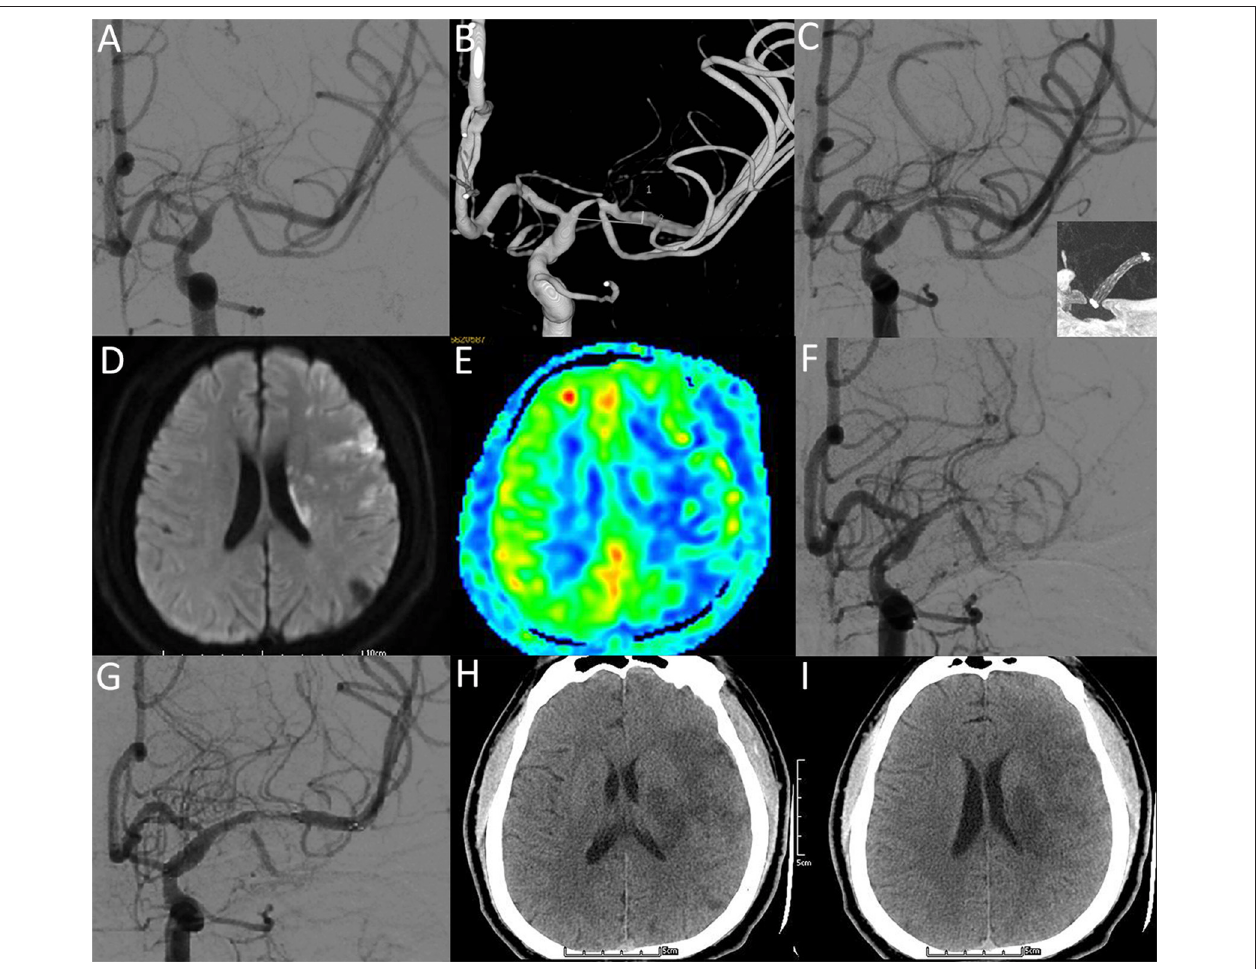
FIGURE 4 | A 28-year-old male with a significant symptomatic stenosis of the left M1 segment. (A,B) Preprocedural DSA image demonstrates high-grade stenosis. (C) Postprocedural DSA image demonstrates a 20% residual stenosis (NIHSS: 0). Insert: VasoCT showing patent stent lumen with good stent vessel apposition. (D-F) Two days after stenting, DWI (D) and ASL (E) images reveal new infarctions and hypoperfusion in the territories of the left MCA (NIHSS: 14). DSA image (F) demonstrates complete occlusion of the left MCA. After the intra-arterial administration of IIb/IIIa inhibitor and solitaire stent deployment, DSA image (G) demonstrates recanalized flow of MCA (NIHSS: 14). Five days after recanalization, CT images (H,I) reveal hypointense lesions within the territories of the left MCA (NIHSS: